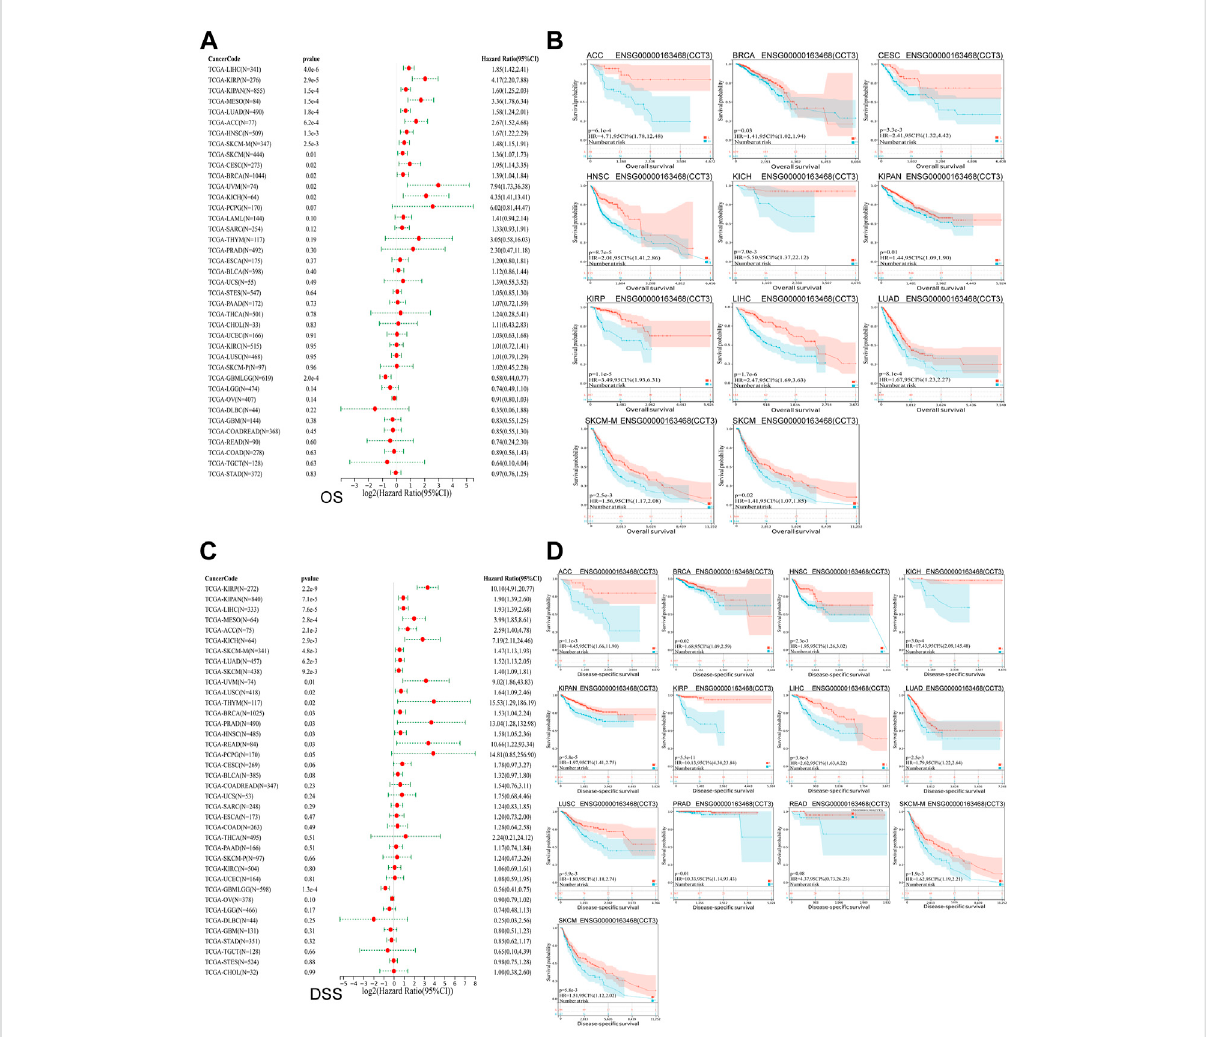
Prognostic value of CCT3 for overall survival (OS) and disease-speci fi c survival (DSS) in pan-cancer. (A) Forest plots showed the correlation betweenCCT3expressionandOSin33cancertypes. (B) TheKMcurvesshowedthecorrelationbetweenCCT3expressionandOSinpan-cancer. (C) Forest plots showed the correlation between CCT3 expression and DSS in 33 cancer types. (D) The KM curves showed the correlation between CCT3 expression and DSS in